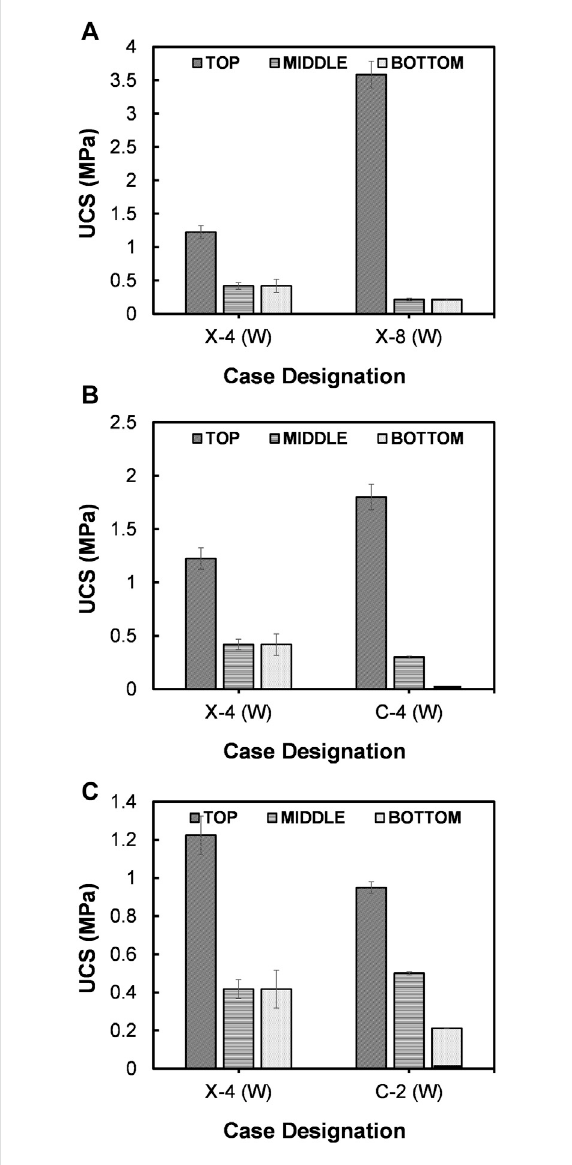
FIGURE 8 Comparison of UCS between the cases treated under (A) different injection frequencies of biological solution, (B) different injection frequencies of cementation media and (C) different injection volumes of cementation media.